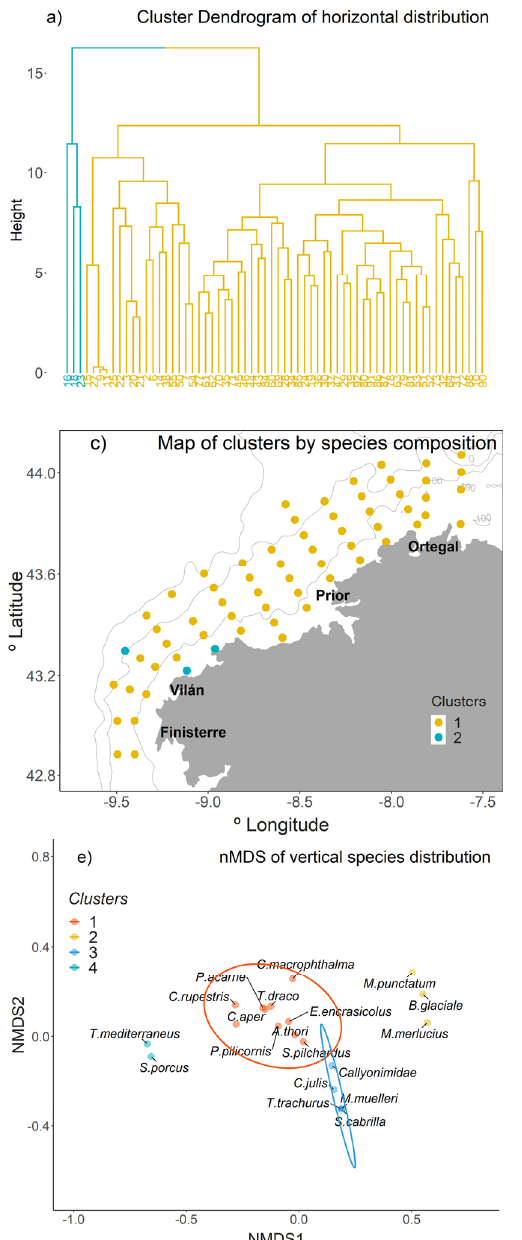
Figure 5. ( a ) Dendrogram, ( b ) NMDS ordination and ( c ) map of the clustering of the horizontal species composition, ( d ) dendrogram, and ( e ) nMDS ordination of the vertical species composition.